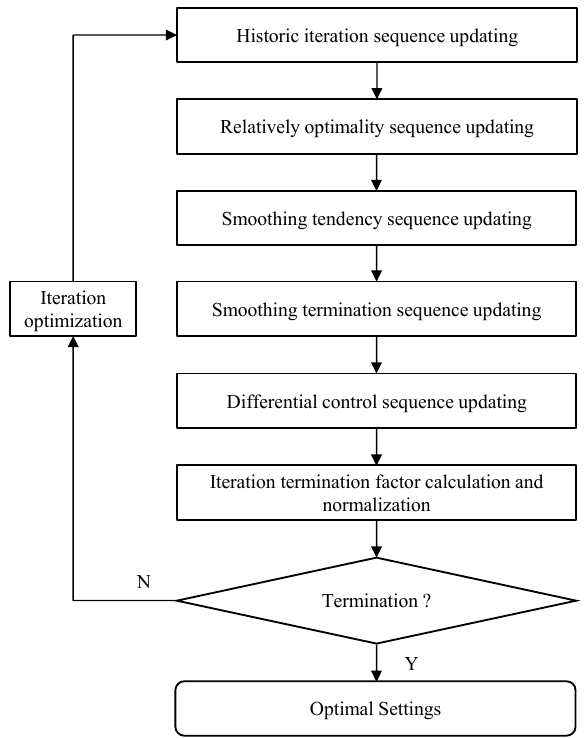
Figure 9. Flowchart of iteration termination control.